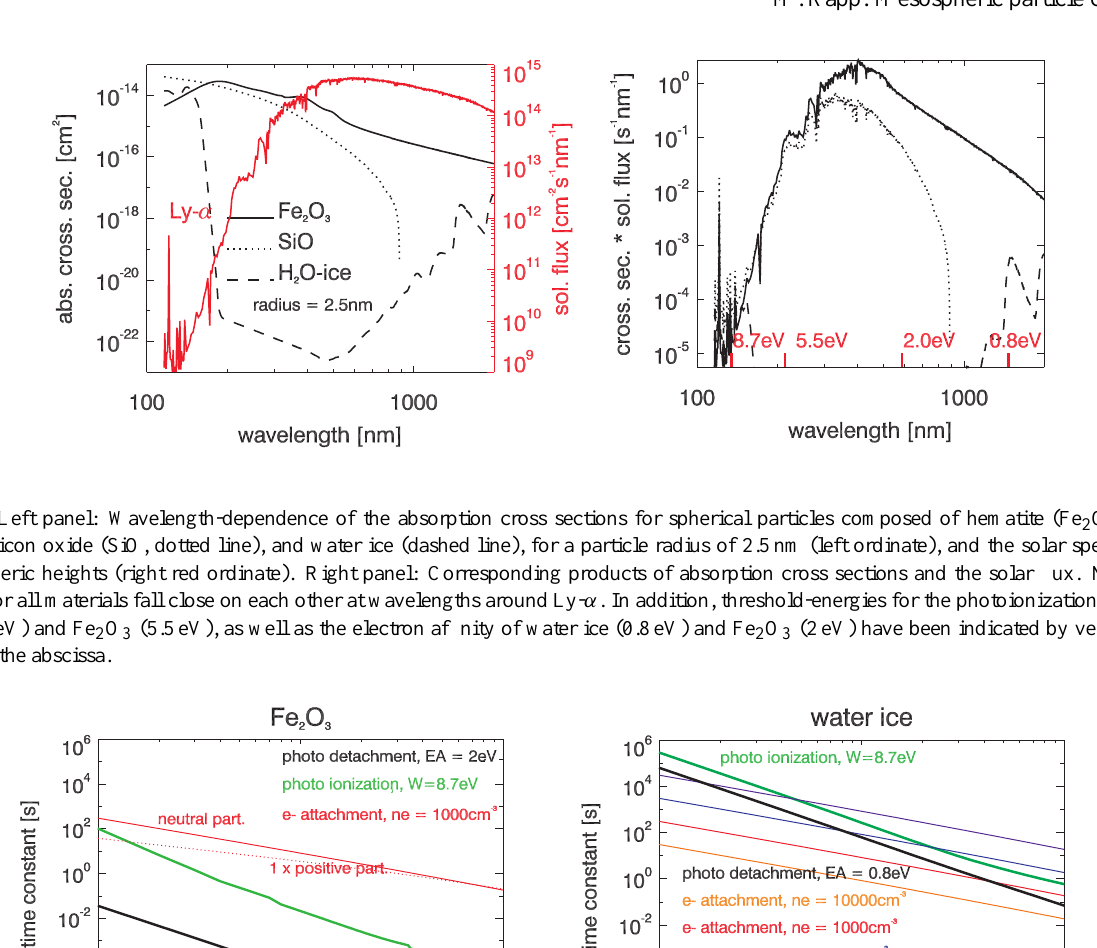
negatively charged under conditions of solar